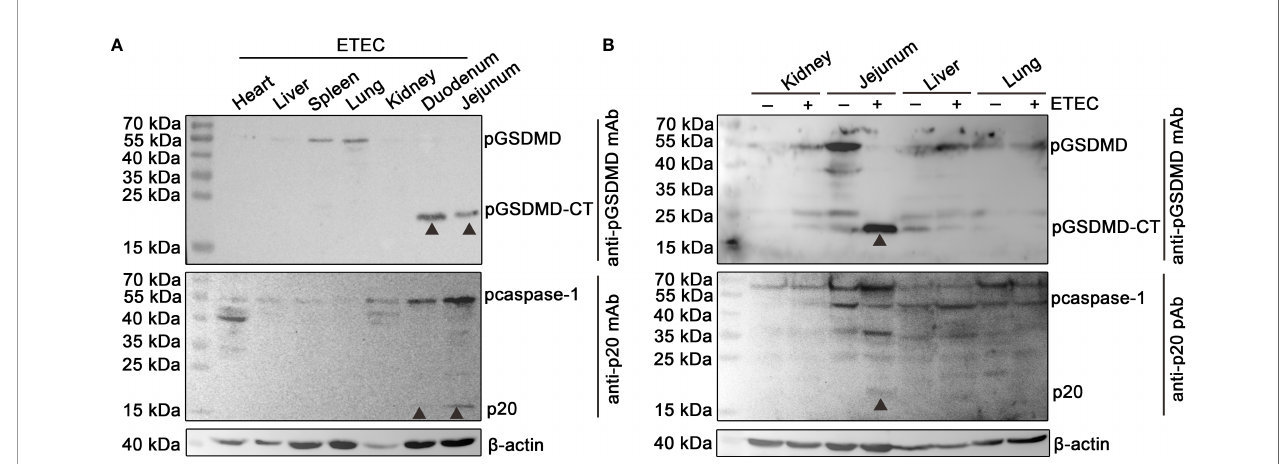
FIGURE 1 | Determination of the activation of pcaspase-1 and cleavage of pGSDMD in tissues of the piglet. (A) Determination of the activation of pcaspase-1 and cleavage of pGSDMD in the tissues of ETEC (F5+) challenged piglet. The heart, liver, spleen, lung, kidney, duodenum and jejunum of a piglet orally challenged with 1×10 11 CFUof ETEC (F5+). (B) Difference in pcaspase-1 activation and pGSDMD cleavage in tissues between the healthy and ETEC (F5+) challenged piglets. The activation of pcaspase-1 and cleavage of pGSDMD in the kidneys, jejunums, livers and lungs of the piglets were analyzed by western blot assay. GSDMD: full-length GSDMD; GSDMD-CT: C-terminal cleavage product of GSDMD; p20: mature